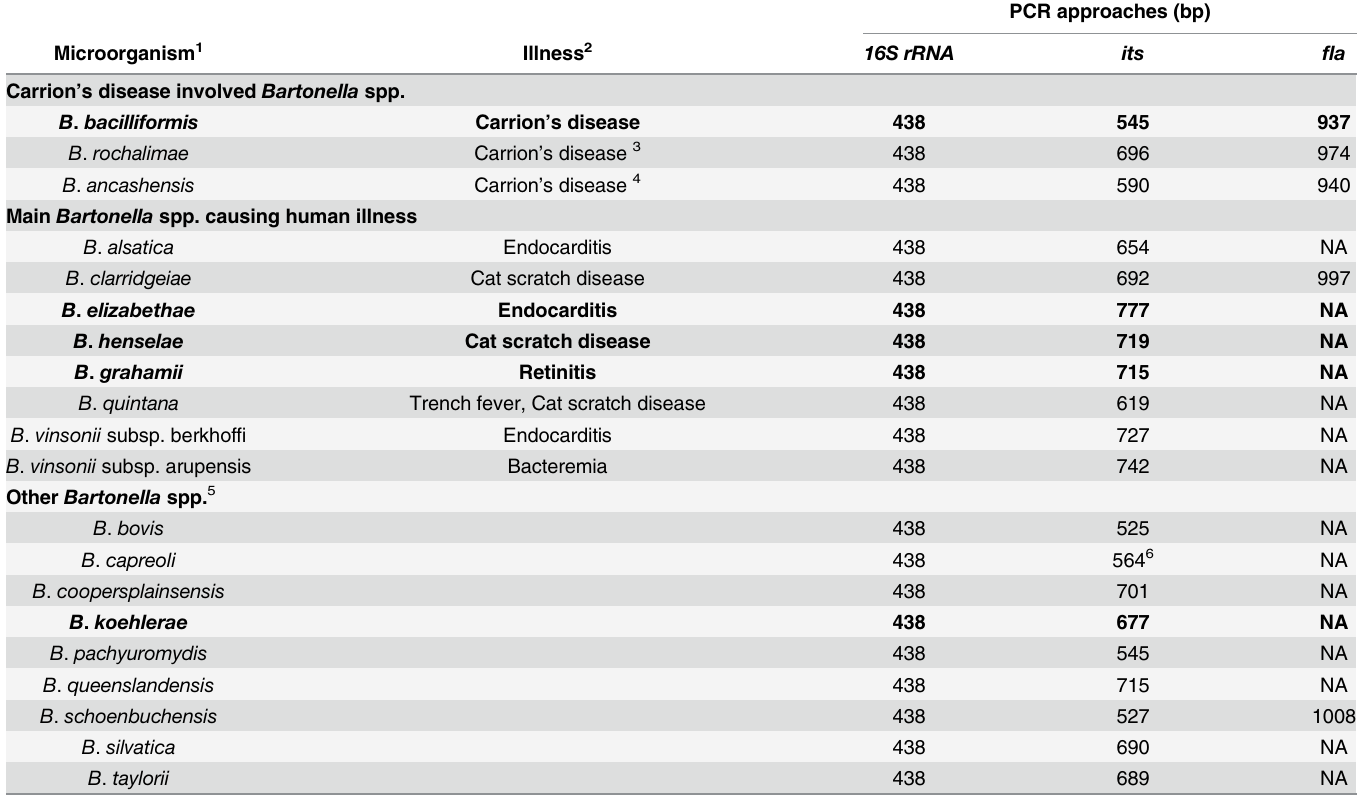
PCR approaches (bp)